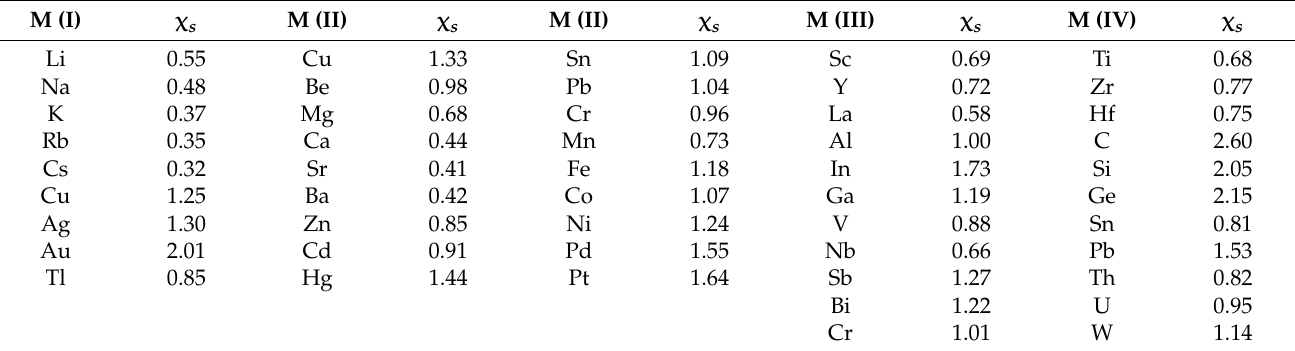
Table 4. Thermochemical electronegativity ( χ s ) of metals in solid compounds.